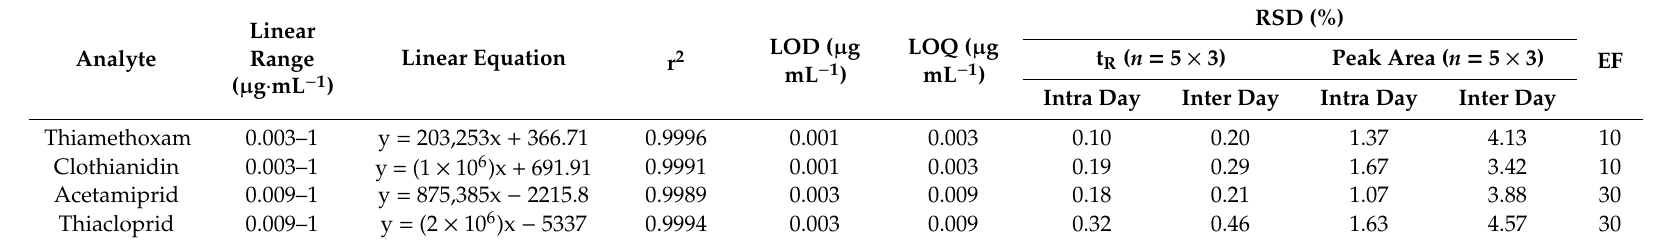
Table 1. Analytical performance of the proposed method for four di ff erent neonicotinoid